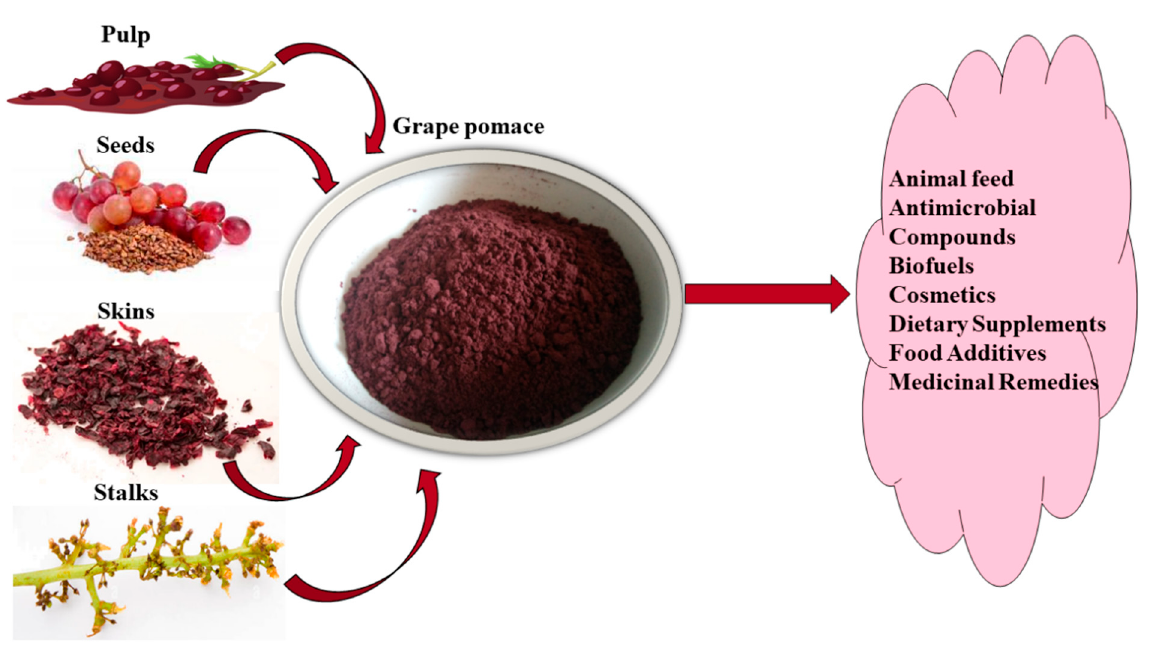
Figure 2. Grape pomace sources and potential applications.